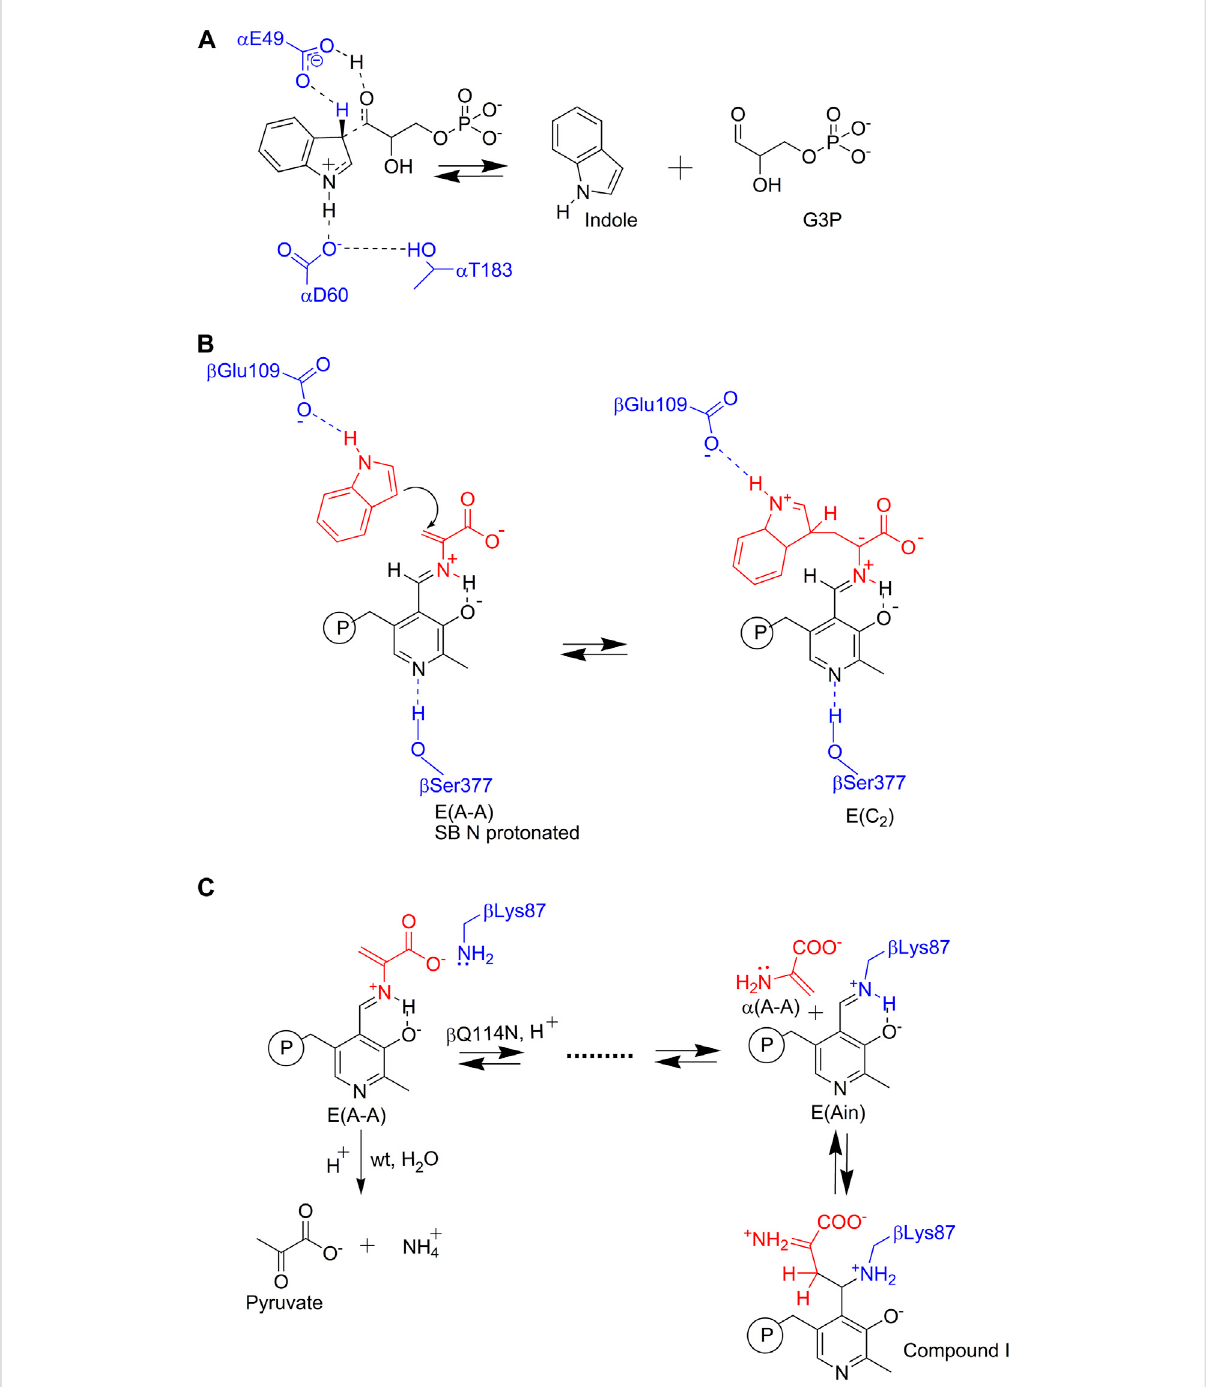
FIGURE 3 NucleophilicreactionscatalyzedbyTS.Inthe α -and β -reactions(Figures1B,C),theC-Cbondscissionandbondformationstepsrequirethereactingindole ring to participate as an enamine wherein the relatively electron rich C3 makes a nucleophilic attack (A) on a proton (in the α -reaction), or (B) on the α - aminoacrylateintermediateC β (inthe β -reaction).Becausetheindoleringsystemisarelativelyweaknucleophile,TShasevolvedamechanismforenhancingthe nucleophilicity of the indole ring C3 throughstabilization of thezwitterionictransition states for protonation (A) or C-C bond formation (B) via Coulombic interaction of the carboxylate ion of an active site residue. At the α -site, it is postulated that the hydroxyl of α L6 loop residue α Thr183 stabilizes this interaction throughahydrogenbondtothe α Asp60carboxylate.Thisinteractiononlyoccursinthe α Rstatewhenloop α L6iswellordered(Kuliketal.,2005).Inthe β -reaction whenindolebindstoitssub-site,the β Glu109carboxylatehydrogenbondstotheN1protonoftheindoleringandthusstabilizesthetransitionstateforC-Cbond formationinthenucleophilicattackofC3onthe α -aminoacrylateC β . (C) The ε NH 2 of β Lys87initiatesadeleterioussidereactionbymakinganucleophilicattackat the PLP C4 ′ resulting in the release of the three-carbon enamine, α -aminoacrylate in the β Q114N mutant (Kulik et al., 2005). This powerful nucleophile then attacks C4 ′ of E(Ain) forming a C-C bond and yields a tightly bound PLP derivative that inactivates the β -site. This complex has a β R